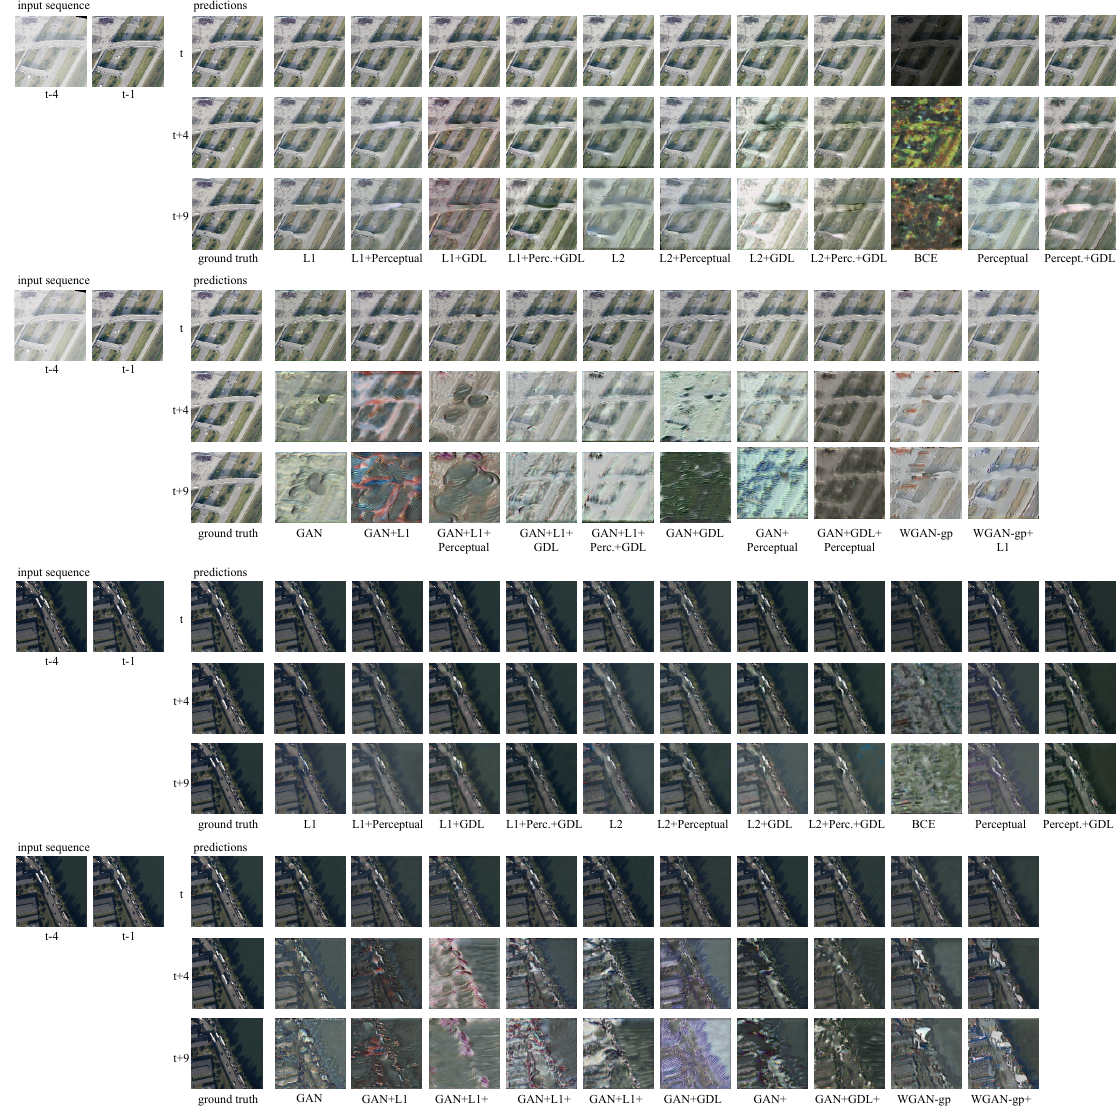
Figure A8. Qualitative results for the KIT AIS Vehicles test split. To generate these images, we used the models that were trained on Cityscapes for 20 epochs. The models were trained to predict the next frame based on four past frames. All images are included in the supplementary material. (The images are best viewed on